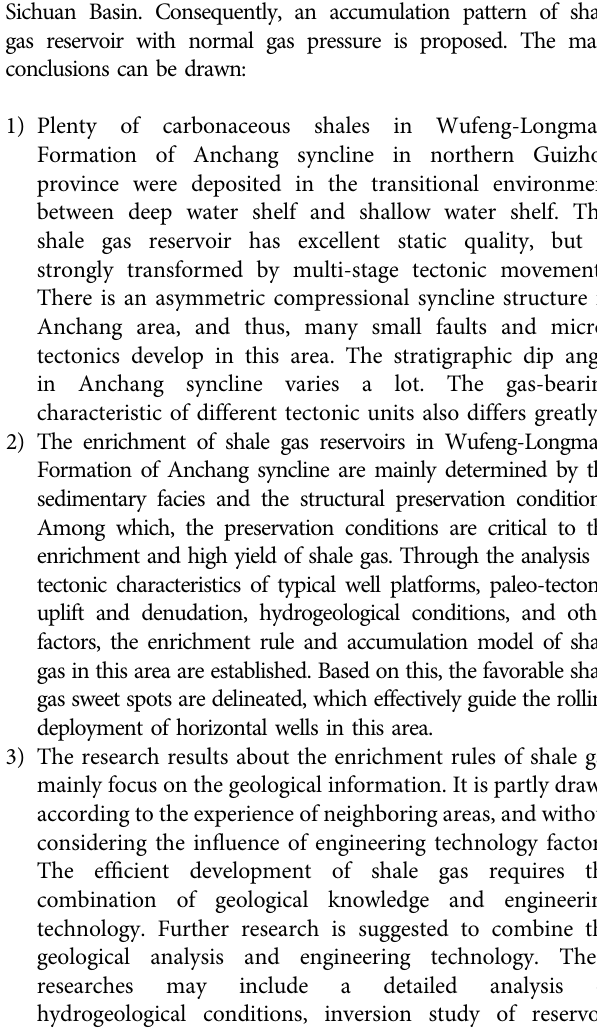
Frontiers in Earth Science |